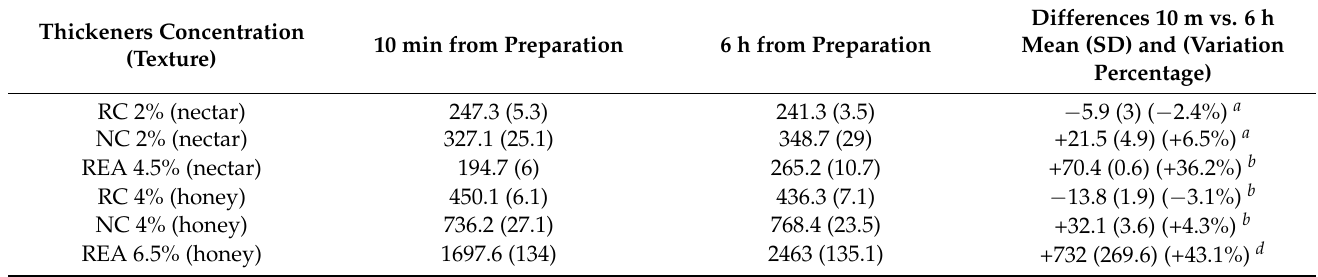
Table 4. Representation of average viscosity in mPa · s as a function of time (10 min, 6 h) after preparation, measured at a shear rate of 50 s − 1 and obtained with different